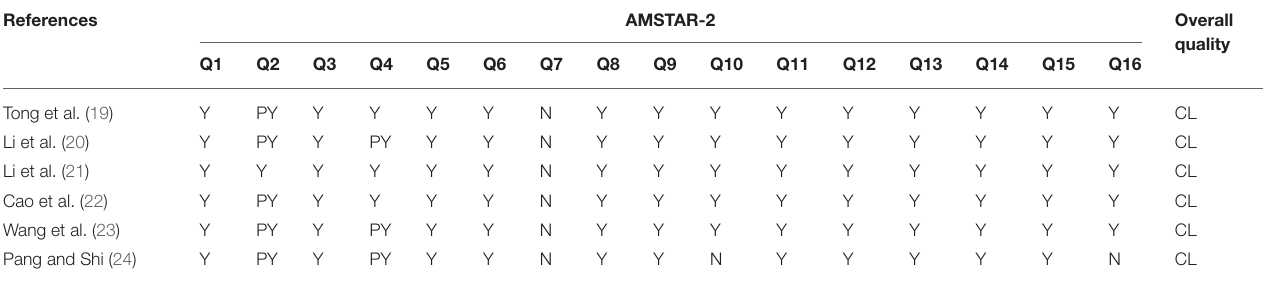
TABLE 3 | AMSTAR-2 assessment